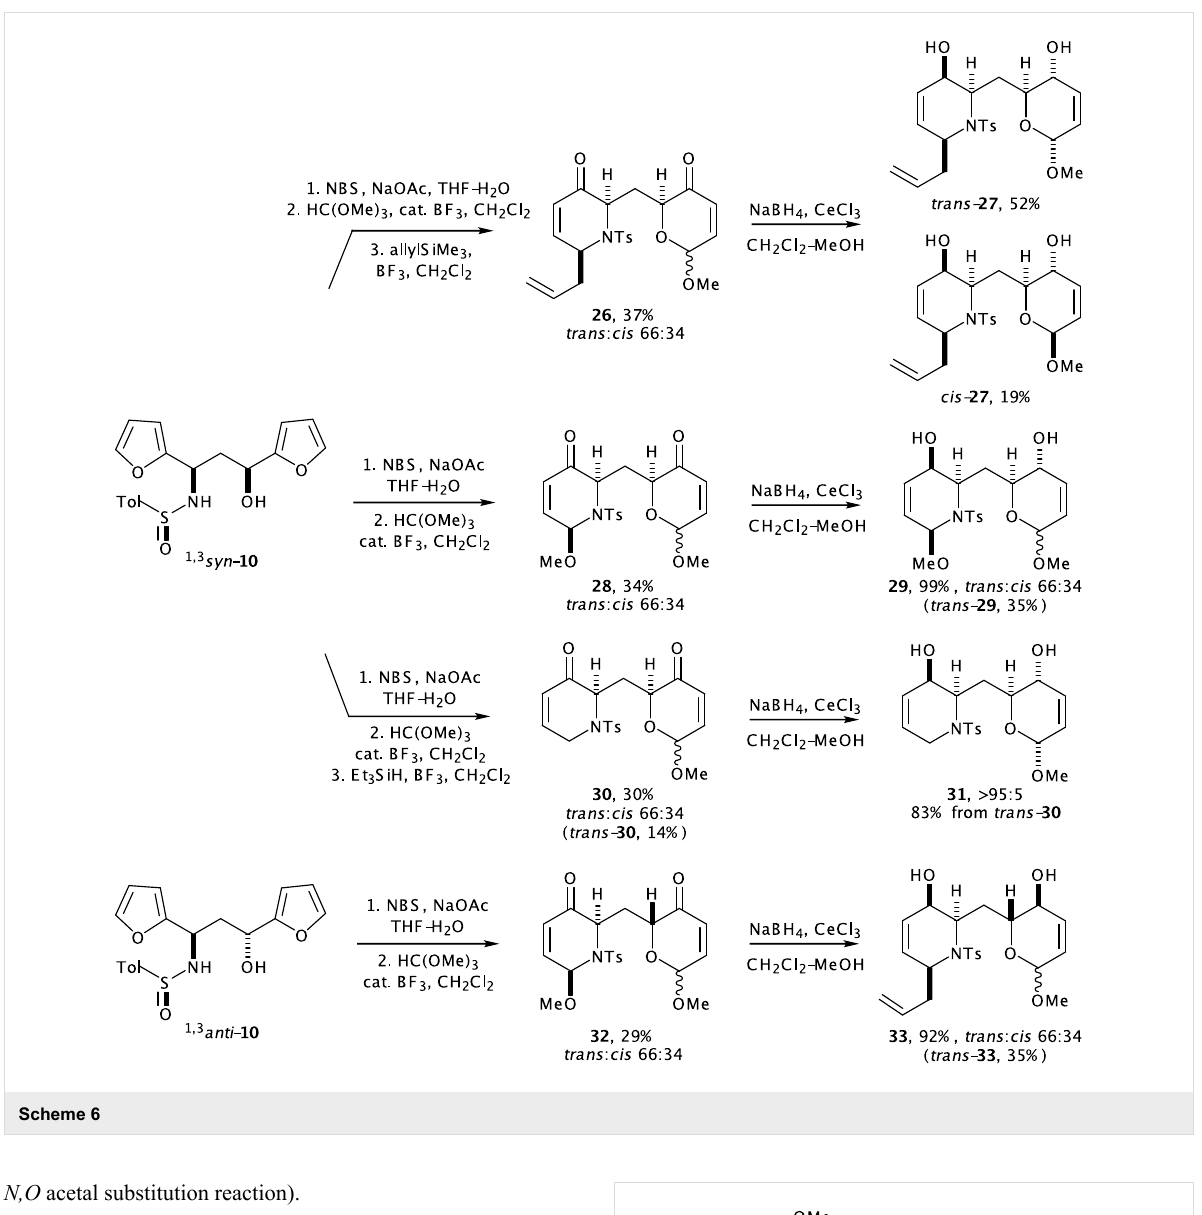
Figure 6: Stereoselectivity of two-directional Luche reductions